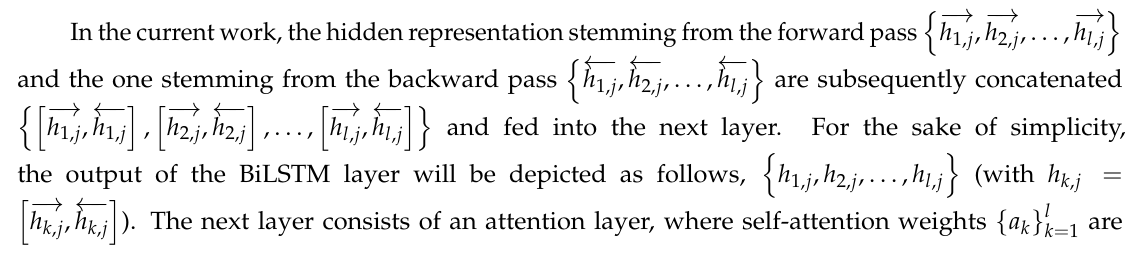
Figure 4. Long Short-Term Memory (LSTM) Recurrent Neural Network